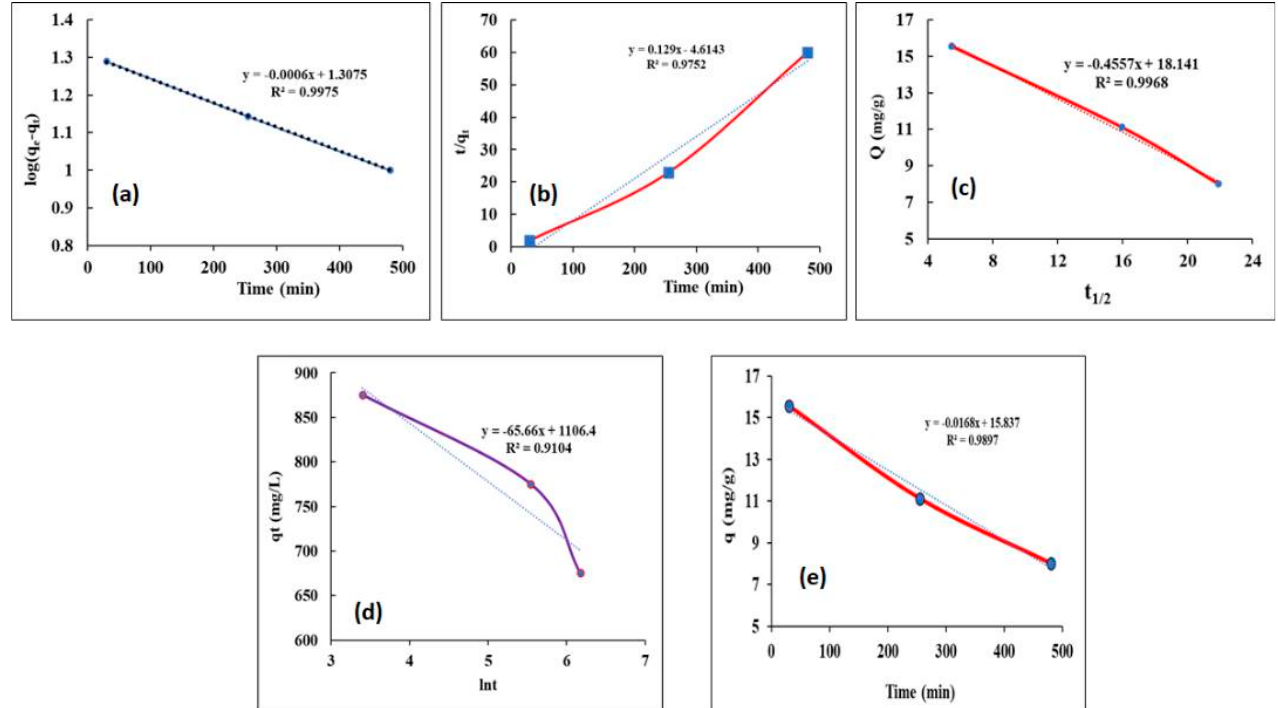
Figure 7. Adsorption kinetics fitted with ( a ) Pseudo-First-Order, ( b ) Pseudo-Second-Order ( c ) Intra- particle Diffusion Kinetics Models, and ( d ) Elovich Kinetic Model ( e ) Effect of adsorption time on the boron adsorption. Table 5. Comparison of the kinetics parameters.